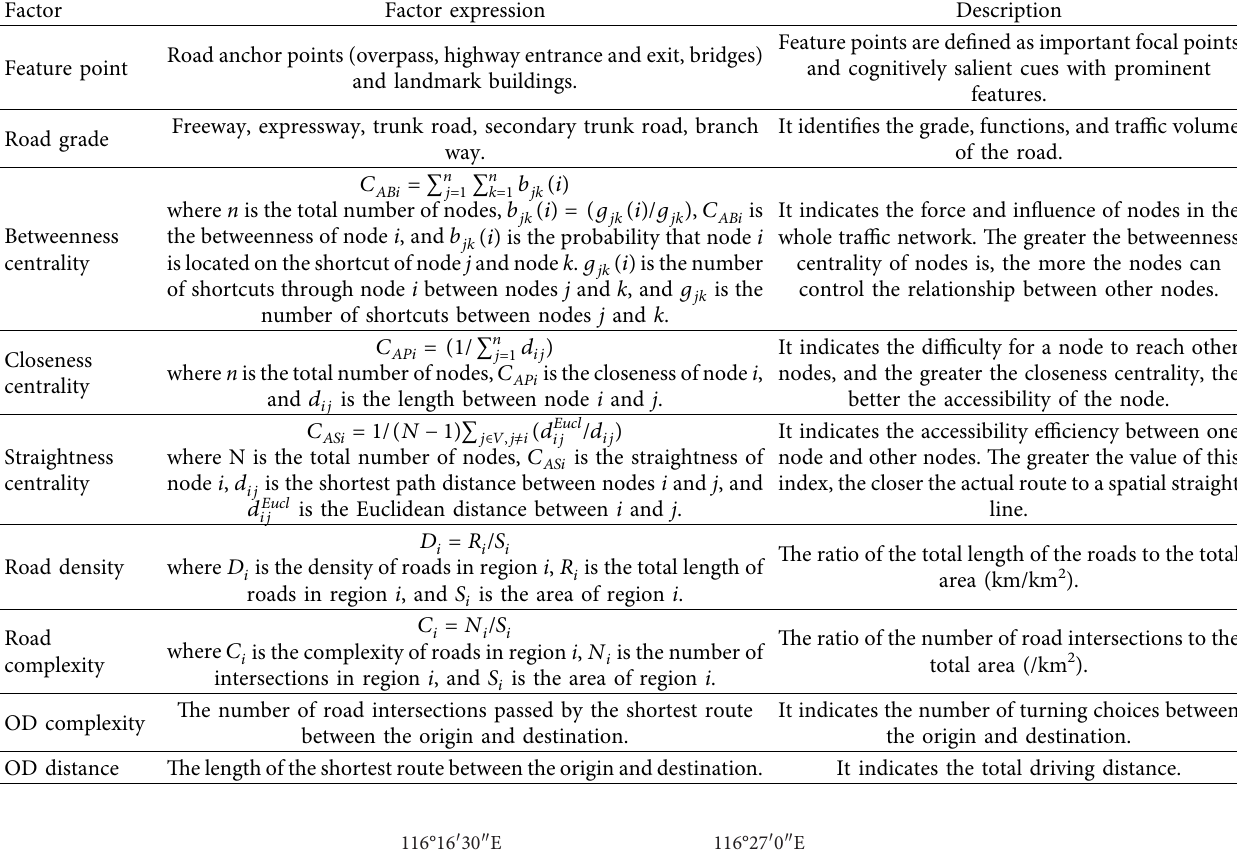
Table 4: Definition and expression of potential correlation